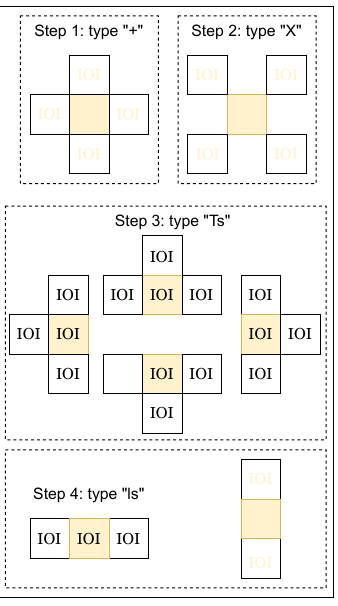
Figure 4. Spatial configuration types in each step of